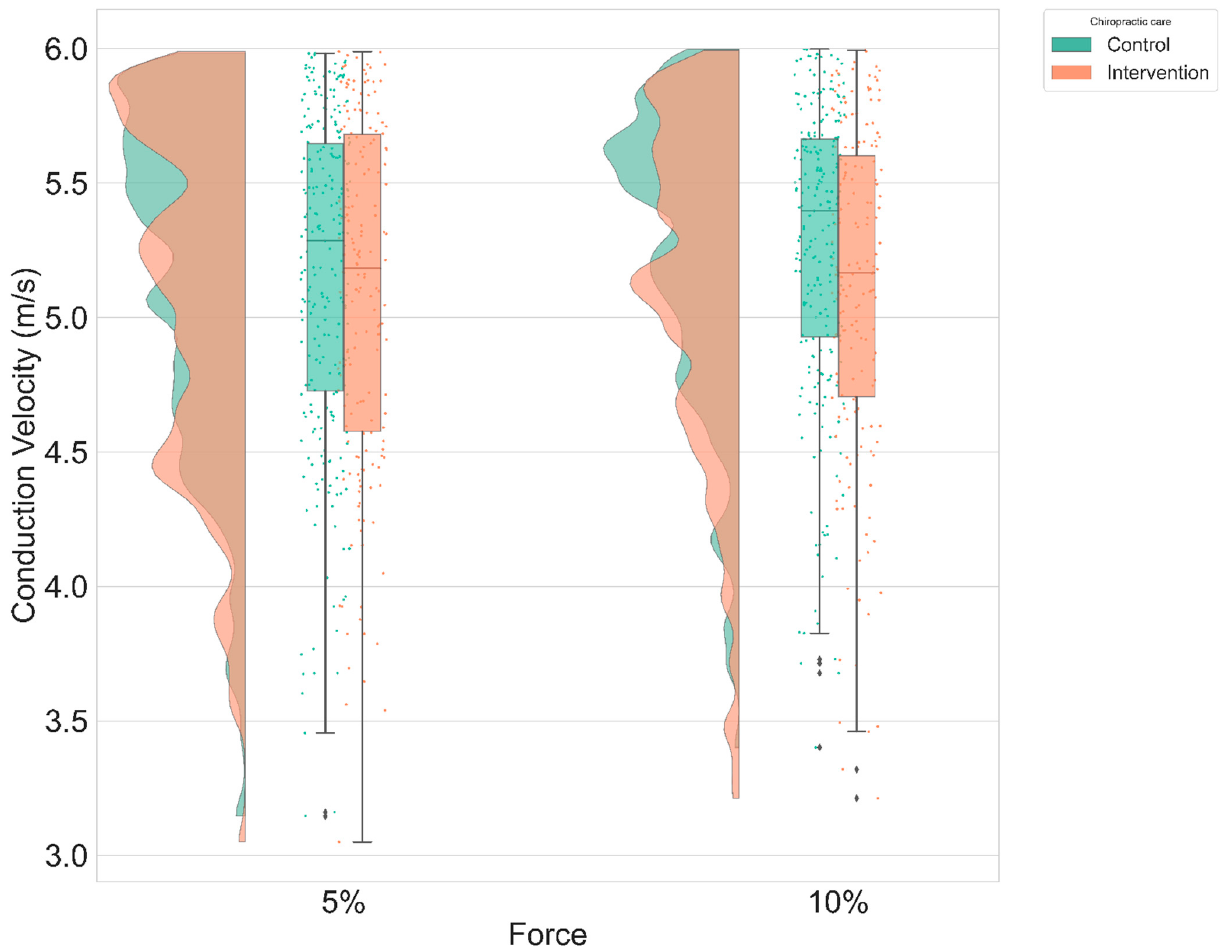
Figure 7. Distribution plot of the CV after intervention (control vs. spinal manipulation) for “ramp & maintain” condition adjusted to baseline.